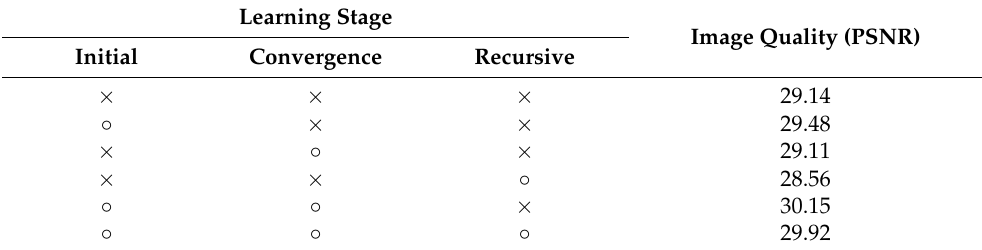
Table 5. Performance comparison according to the use of the proposed objective function.